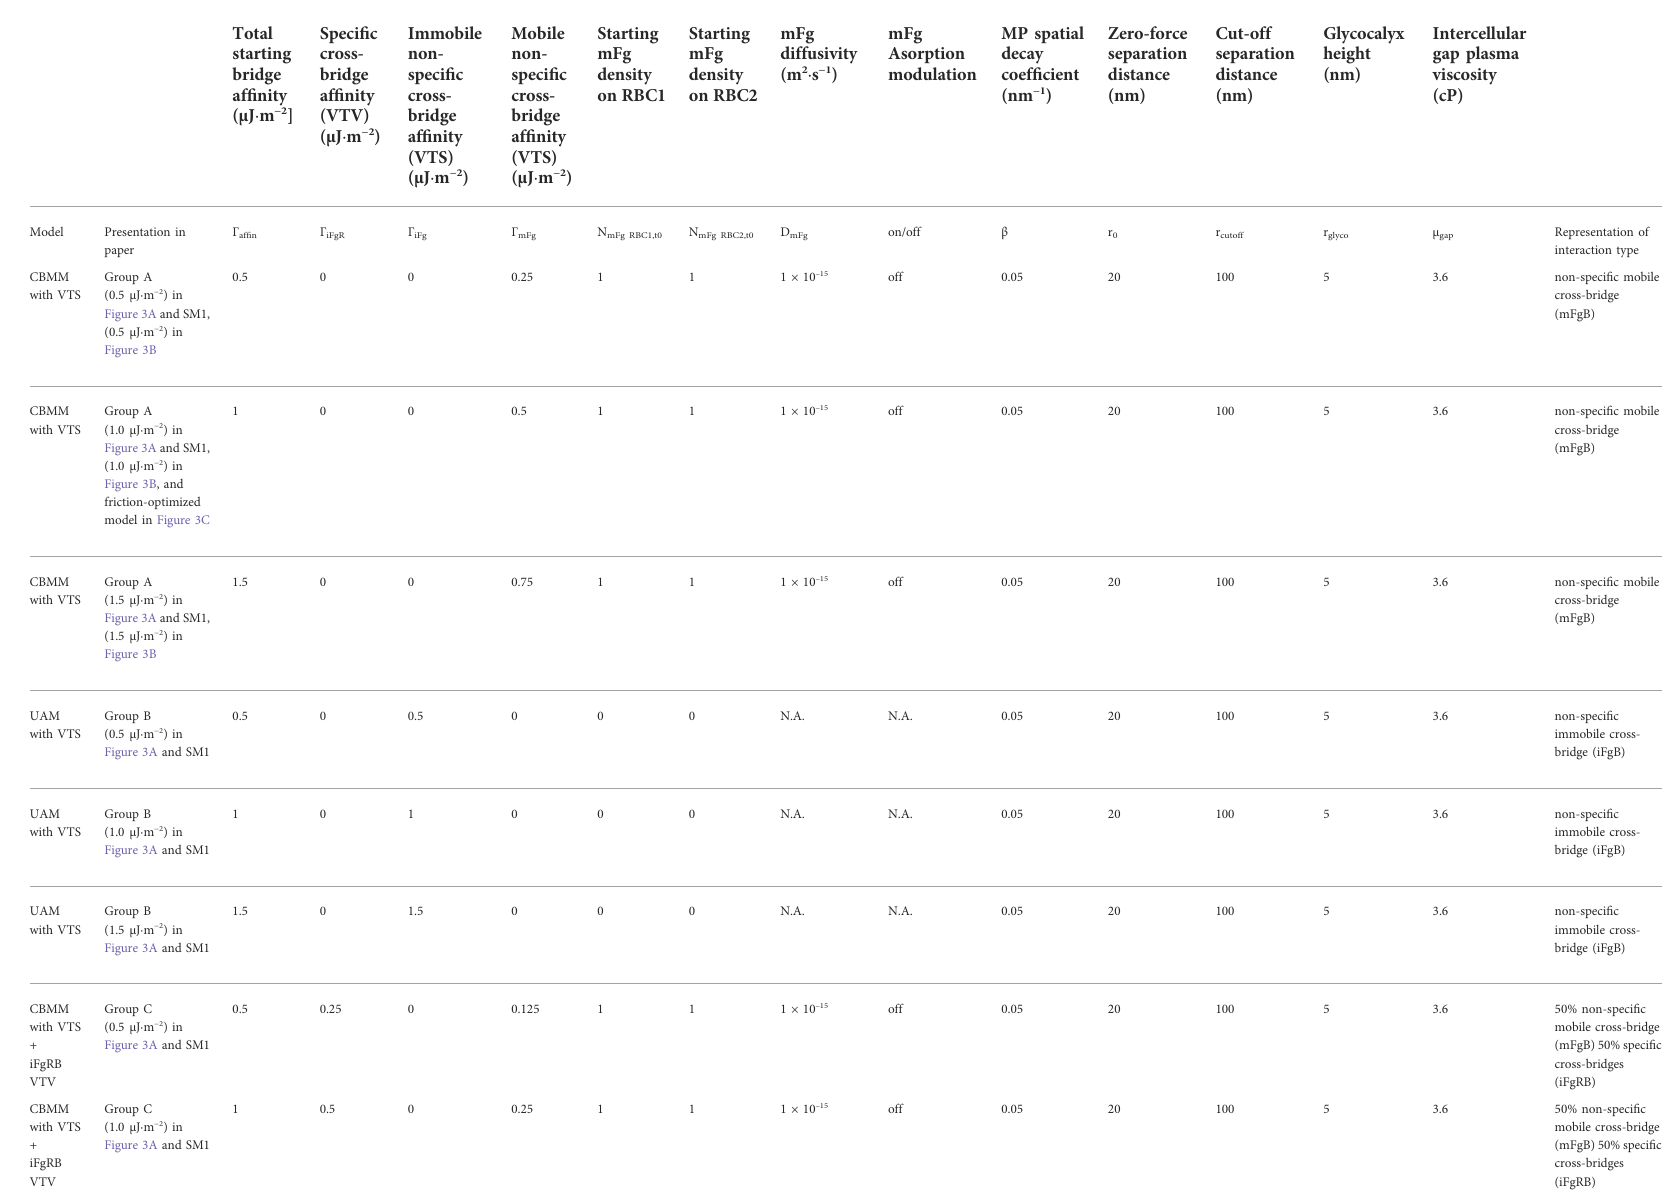
TABLE 2 Simulation parameters for doublet formation